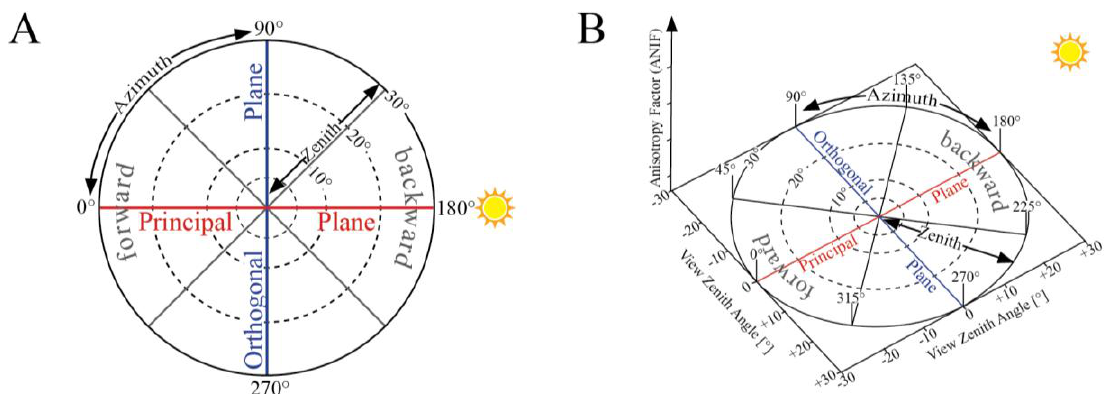
Figure 6. ( A ) Polar coordinate system used for presenting BRDF data in 2D plots; ( B ) Polar coordinate system used for presenting BRDF data in 3D plots.